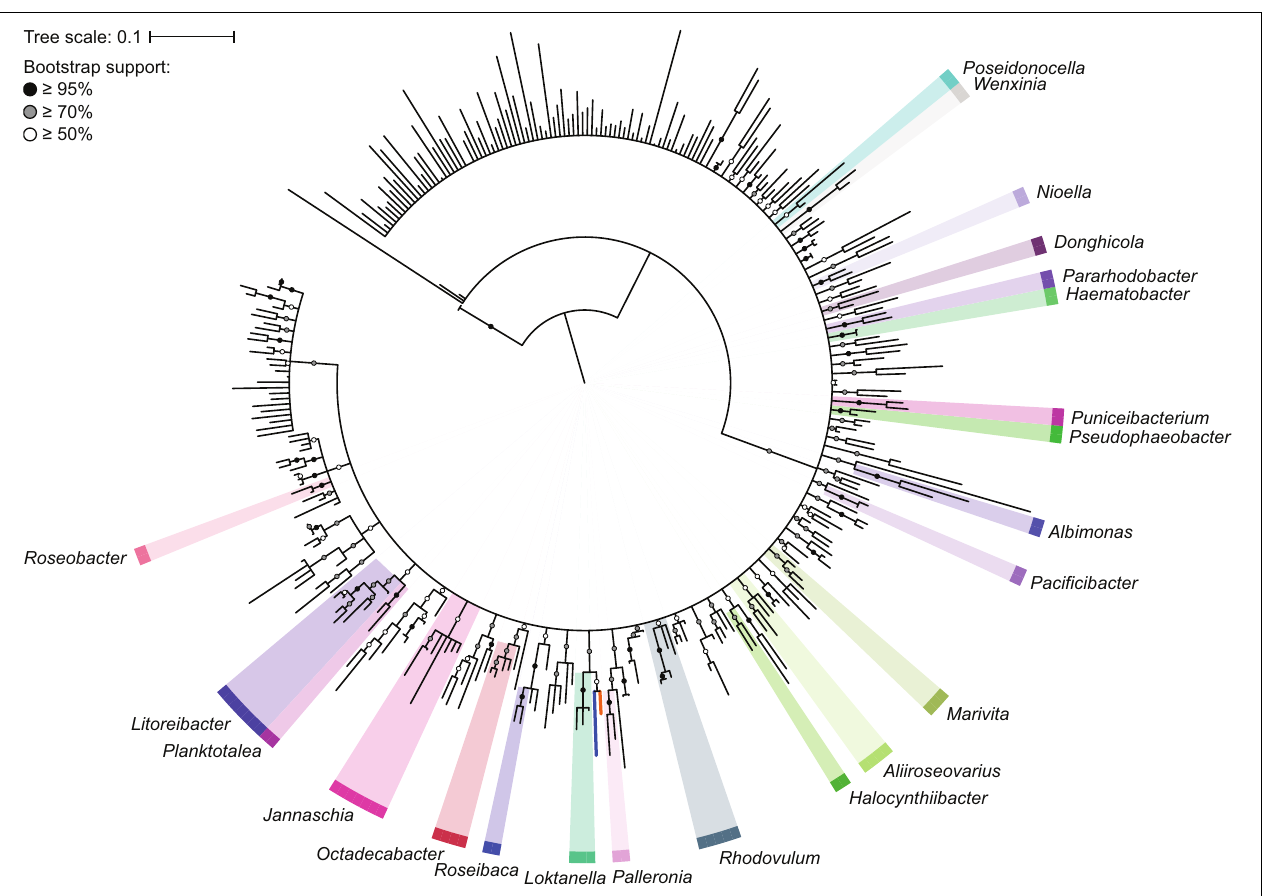
FIGURE 1 | Phylogenetic tree of 331 Rhodobacteraceae type strains based on the full-length 16S rRNA gene (1,698 nucleotide positions). The maximum-likelihood tree was reconstructed using RAxML 8.2.11 with the GTRGAMMA model and rooted with three A. tumefaciens strains. Branch support is evaluated with 1,000 bootstrap replicates and indicated on the nodes as black ( ≥ 95%), gray ( ≥ 70%), or white ( ≥ 50%) circles; nodes with < 50% bootstrap support are collapsed. The scale bar represents nucleotide substitutions per site. All monophyletic genera based on this collapsed 16S rRNA gene tree are highlighted. The blue branch marks the position of Y. vestfoldensis ; the orange branch marks the position of F. marinus